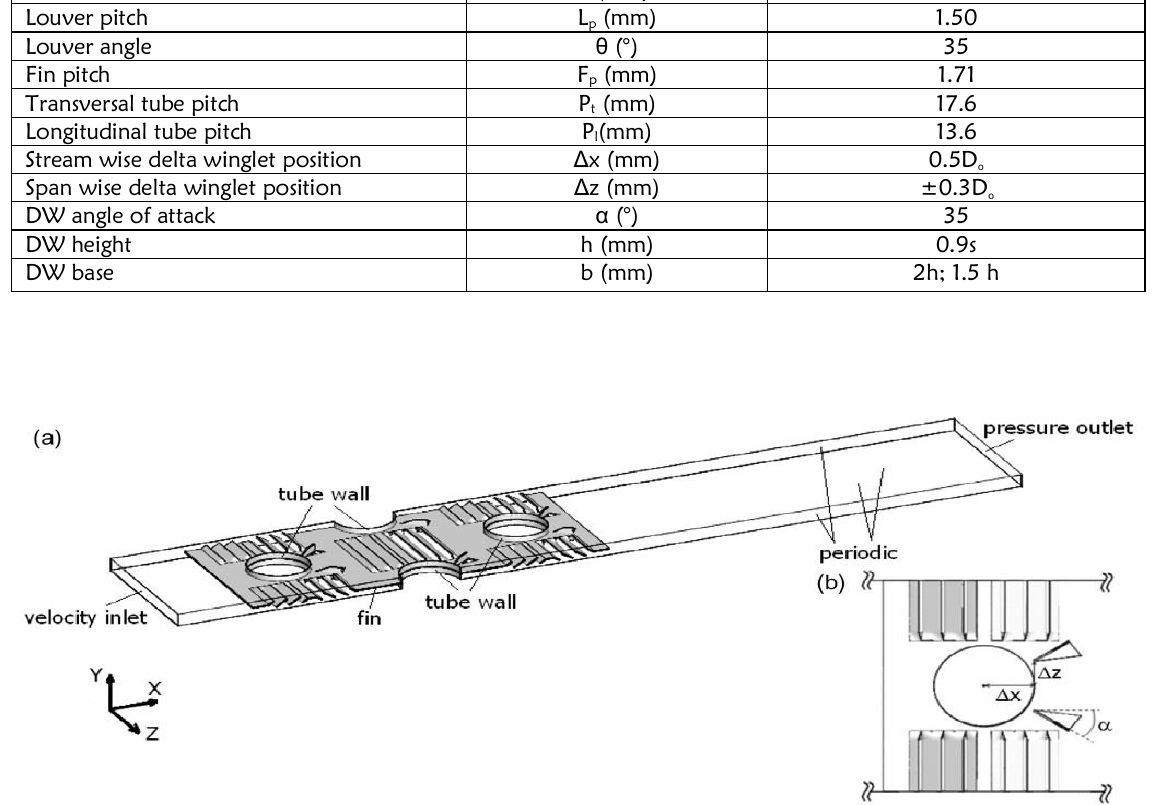
Figure 14: (a) three-dimensional computational domain& (b) top view showing the delta winglet position [27].